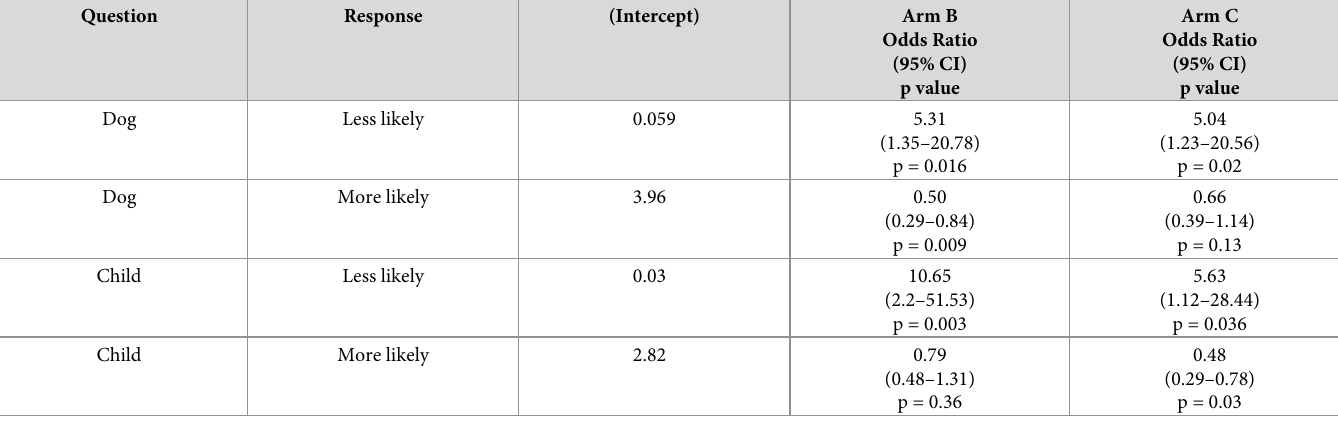
Table 6. Likelihood of participation in joint programme. The output of multinomial logistic regression analysis investigating whether the experience of the integrated programme impacted survey responses. The two survey questions that were analysed asked i) whether respondents would be more or less likely to have their dogs vacci- nated if the delivery was integrated with the child deworming (Question = Dog) and ii) whether respondents would be more or less likely to bring their children for deworming treatment if the delivery was integrated with the rabies vaccination (Question = Children). Arm A was the baseline factor against which Arm B and C were compared. The odds ratios (95% confidence intervals and p-values) for the likelihood of the responses in Arm B and C, as compared to Arm A, are given. Arm A received both dog vaccination and deworming for children. Arm B received deworming for children only and arm C received dog vaccination only. S1 Data.